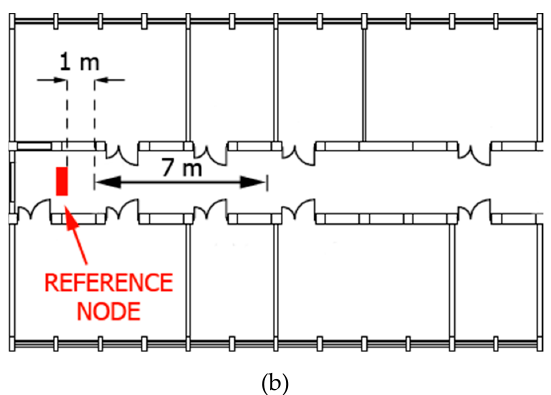
Figure 2. Two-dimensional plans of the indoor measurement environments: ( a ) hall, ( b ) corridor.